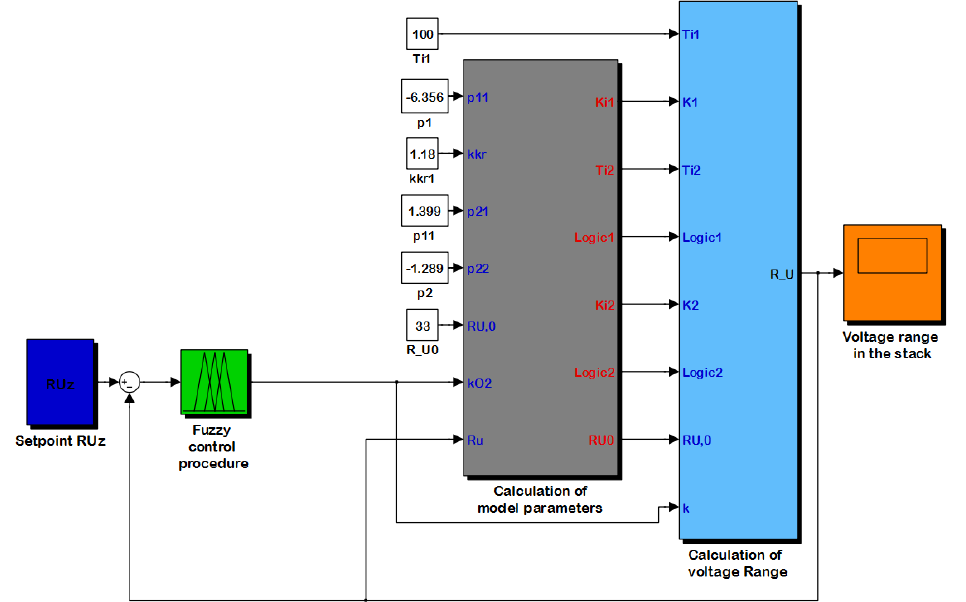
Figure 9. Simulation model of fuzzy control procedure of oxygen flow in PEM fuel cell system.